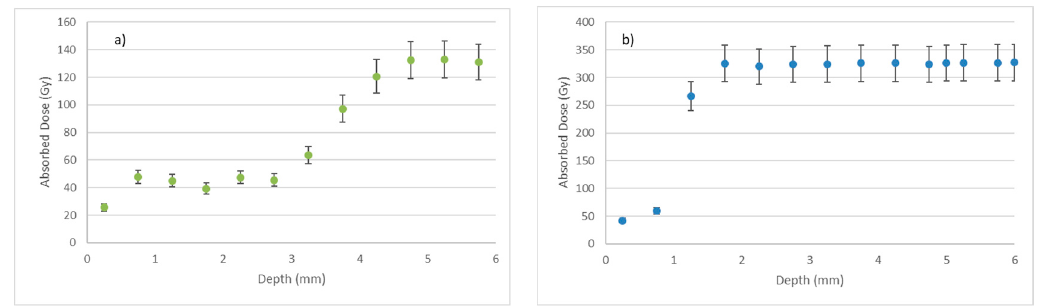
Figure 4. Luminescence depth-profiles ( a ) 1 / 2016 sample; ( b ) 3 / 2016 sample.